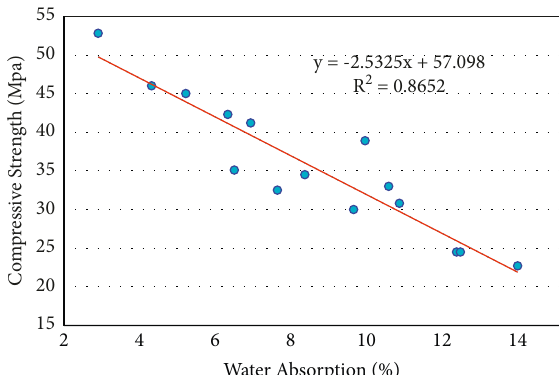
Figure 10: Relationship between compressive strength and water absorption.